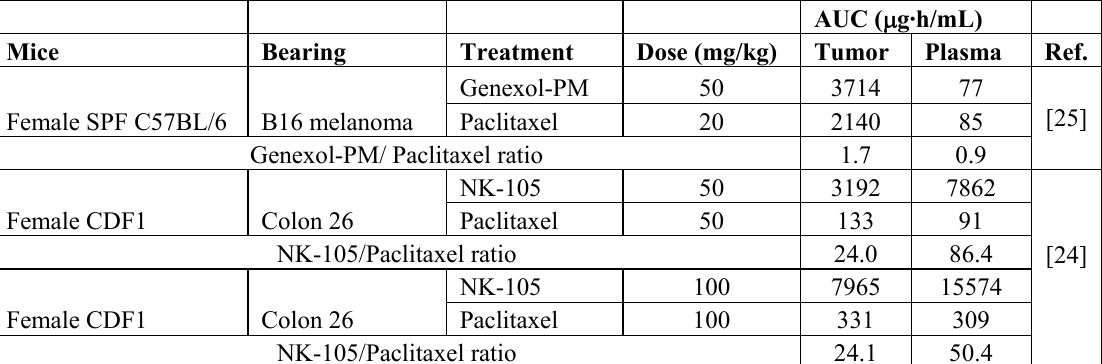
Table 5 . Plasma pharmacokinetics and tumor accumulation of polymeric paclitaxel micelles and paclitaxel in mouse